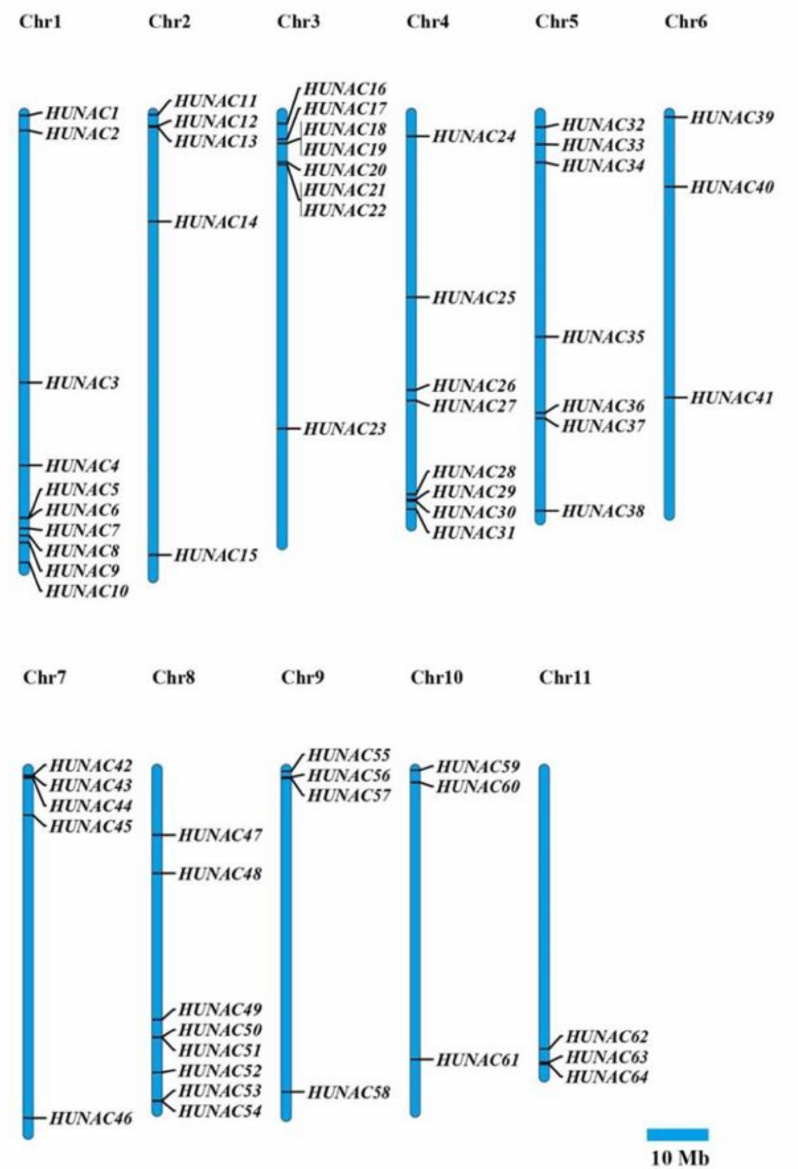
Figure 3. Schematic diagrams of the chromosomal location of the HuNAC genes. Eleven chromosomes with varying lengths are shown on the megabases (Mb) scale on the left, and the chromosome number is shown on top of each